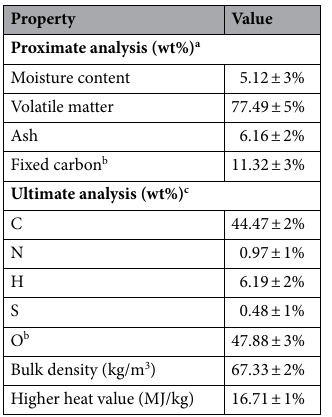
Table 1. The composition and characteristics of raw corn stover. [ a Dry basis, b Calculated by difference, c Dry and ash-free basis].